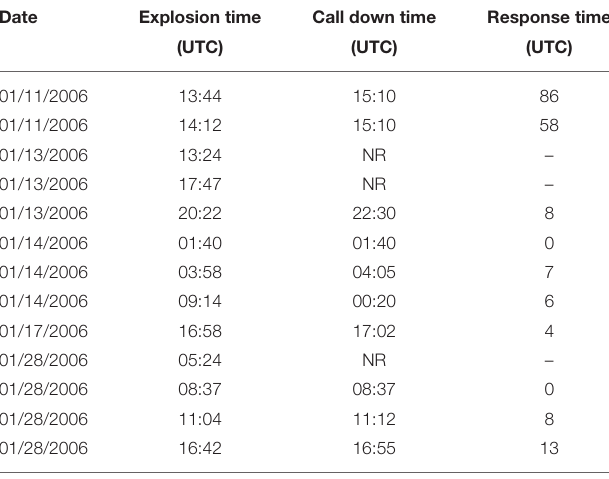
TABLE 2 | Times of explosions onset, call down time, and response time for explosive events that occurred at Augustine Volcano in